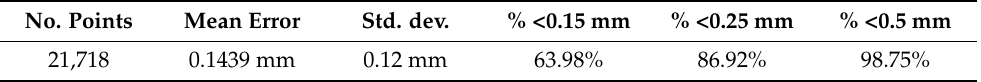
Figure 14. ( a ) Reconstructed wound point cloud aligned to high precision ground truth mesh (green); ( b ) Result of the point cloud to mesh distance measurement, where each point is colored according to calculated error value and in accordance with the color bar on the right side of the figure. Table 1. Result of point cloud to mesh absolute distance calculation.